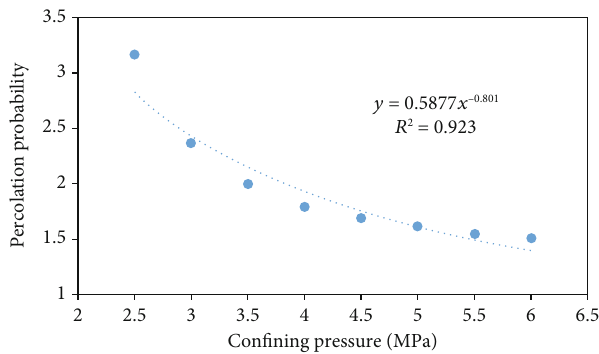
Figure 9: Variation of percolation probability with con fi ning pressure.